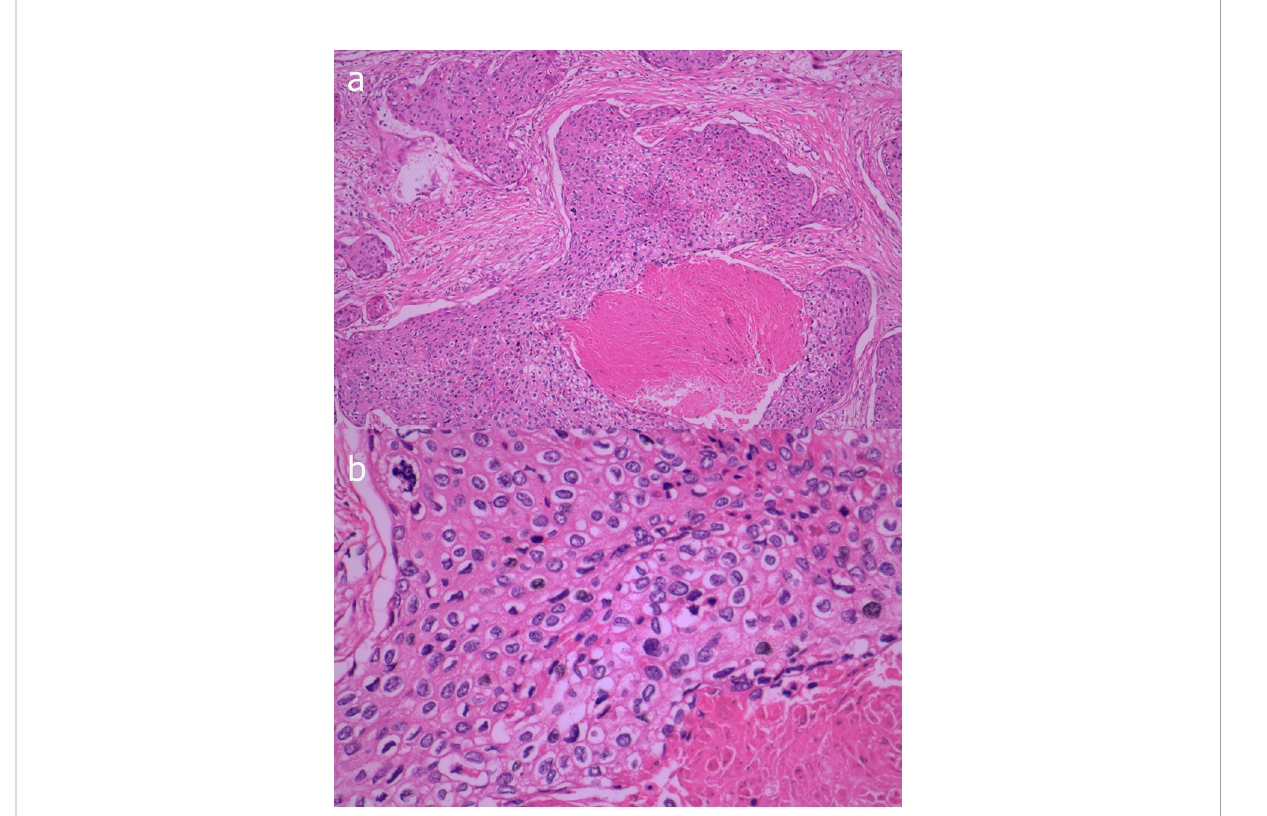
FIGURE 3 Photomicrograph shows many clumps composed of epithelial cells under the skin, the clumps are lobulated and the marginal cells are distributed in a palisade shape, with obvious keratinization in the center, but lacking a granular layer ( A , HE×100). In the outer cells, there are obvious cytological atypia and nuclear pleomorphism ( B ,